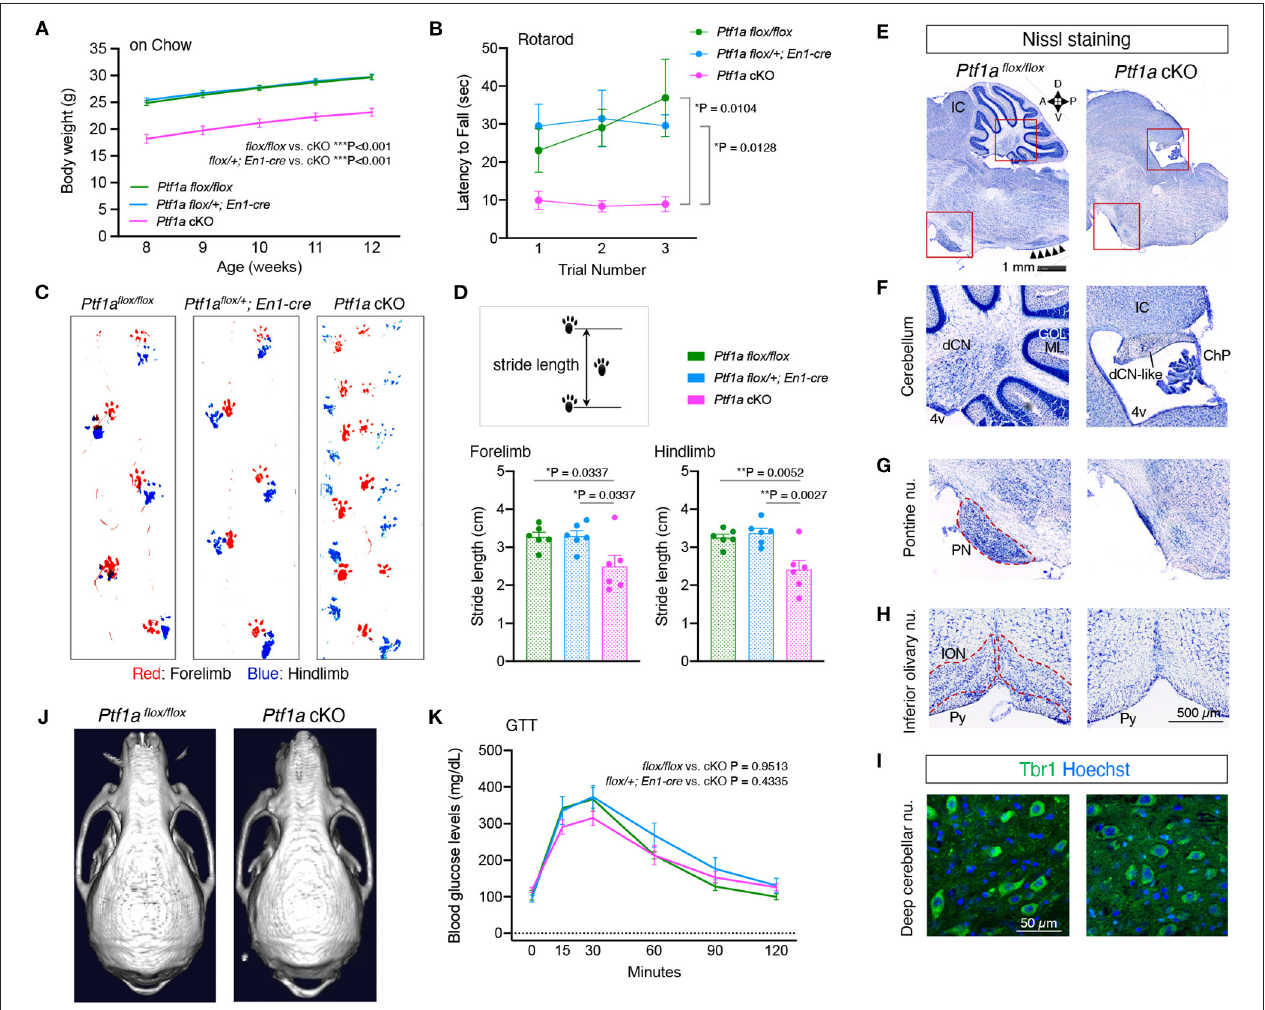
FIGURE 1 | Loss of Ptf1a in the En1 -lineage results in lack of cerebellar cortex. (A) Body weight curves of male Ptf1a cKO and two control groups ( Ptf1a flox / flox , or En1 cre / + ; Ptf1a flox / + ) at the young-adult stages ( n = 15 for Ptf1a flox / flox , n = 25 for En1 cre / + ; Ptf1a flox / + , n = 16 for En1 cre / + ; Ptf1a flox / flox , two-way ANOVA with Sidak’s multiple comparisons test). (B) Latency to fall on the rotarod over three training trials in adult male Ptf1a cKO and control groups ( n = 11 for Ptf1a flox / flox , n = 9 for En1 cre / + ; Ptf1a flox / + , n = 10 for En1 cre / + ; Ptf1a flox / flox , two-way ANOVA with Sidak’s multiple comparisons test). (C) Representative walking footprint patterns of each genotype. An uncoordinated pattern is observed in Ptf1a cKO mice. (D) Stride length is measured in the gait analysis. Quantitative analyses of forelimb (left panel) and hindlimb (right panel) footprints ( n = 6 for each genotype, one-way ANOVA with Holm-Sidak multiple comparisons test). (E–H) Nissl staining of midline sagittal sections (E–G) and coronal sections (H) from adult Ptf1a cKO (right) and control (left) brains showing lack of cerebellar cortex, pontine nuclei, and inferior olivary nucleus. Arrowheads in (E) delineate the laminar structure at the ION region observed in control, but not in cKO mutant. IC, inferior colliculus; dCN, deep cerebellar nucleus; GCL, granule cell layer; ML, molecular layer; 4v, fourth ventricle; dCN-like, residual deep cerebellar nucleus; ChP, choroid plexus; PN, pontine nuclei; ION, inferior olivary nucleus; Py, pyramidal tract. (I) Immunofluorescence of cerebellar sections for the dCN glutamatergic projection neuron marker Tbr1 in an adult Ptf1a cKO compared to a control. (J) Representative skull CT images of adult Ptf1a cKO and control mice. (K) Glucose tolerance test in 4 to 6-month-old male Ptf1a cKO and control groups ( n = 7 for Ptf1a flox / flox , n = 6 for En1 cre / + ; Ptf1a flox / + , n = 7 for En1 cre / + ; Ptf1a flox / flox , one-way ANOVA with Tukey’s multiple comparisons test). All data are expressed as the mean ±